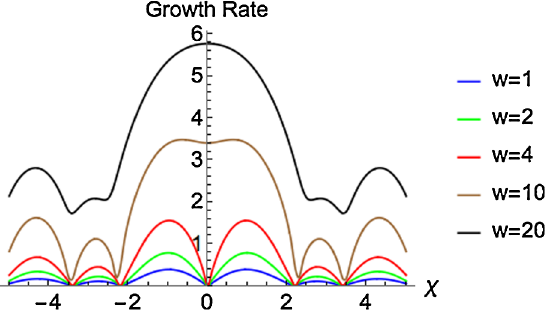
7. Round chamber, reactive damper, gT ¼ 1